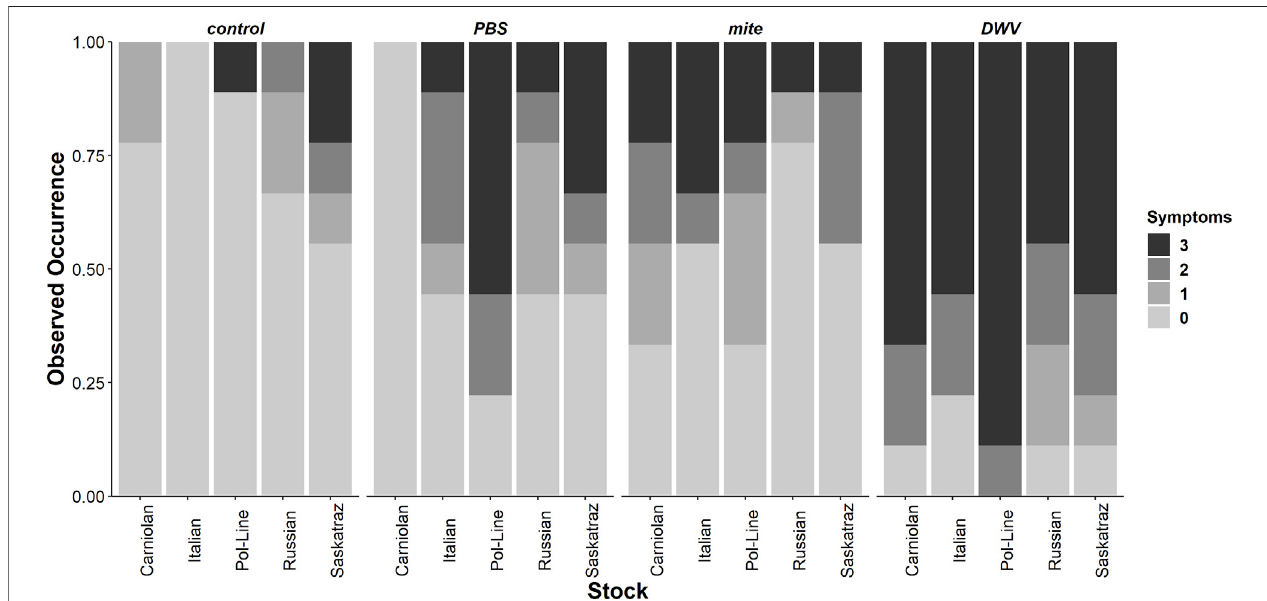
FIGURE 6 | Observed rates of DWV symptom severity. The observed rates of symptom severity for each stock and treatment combination for the subset of bees used for viral analyses (N = 9 bees per stock × treatment combination, N = 180 bees total) indicate signi fi cant bee stock × treatment interactions. Contrary to expectations, these interactions are not consistent for all Varroa mite – resistant stocks (Pol-Line, Russian, and Saskatraz). Zero represents no symptoms and 3 represents debilitating morphological symptoms based on Supplementary Figure S1 . Supplementary Table S4 for mean DWV levels for each bee stock and symptom severity